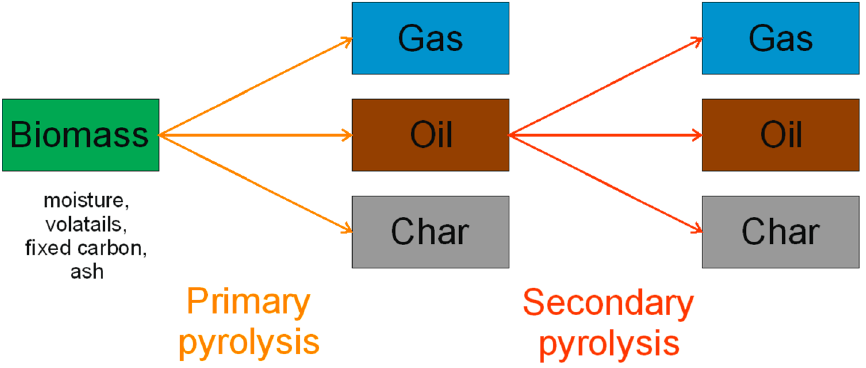
Figure 1. Decomposition of biomass in the pyrolysis process. Table 1. General advantages and disadvantages of pyrolysis process [18–20].